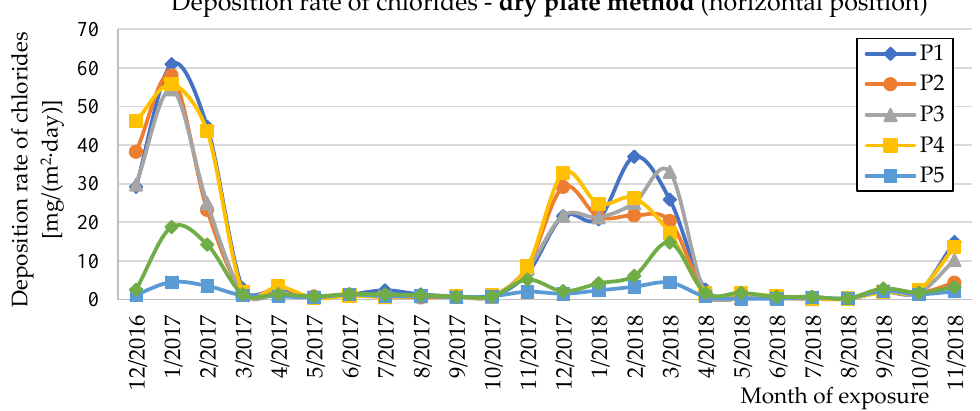
Figure 10. Deposition rates of chlorides determined by the dry plate method (horizontal position).